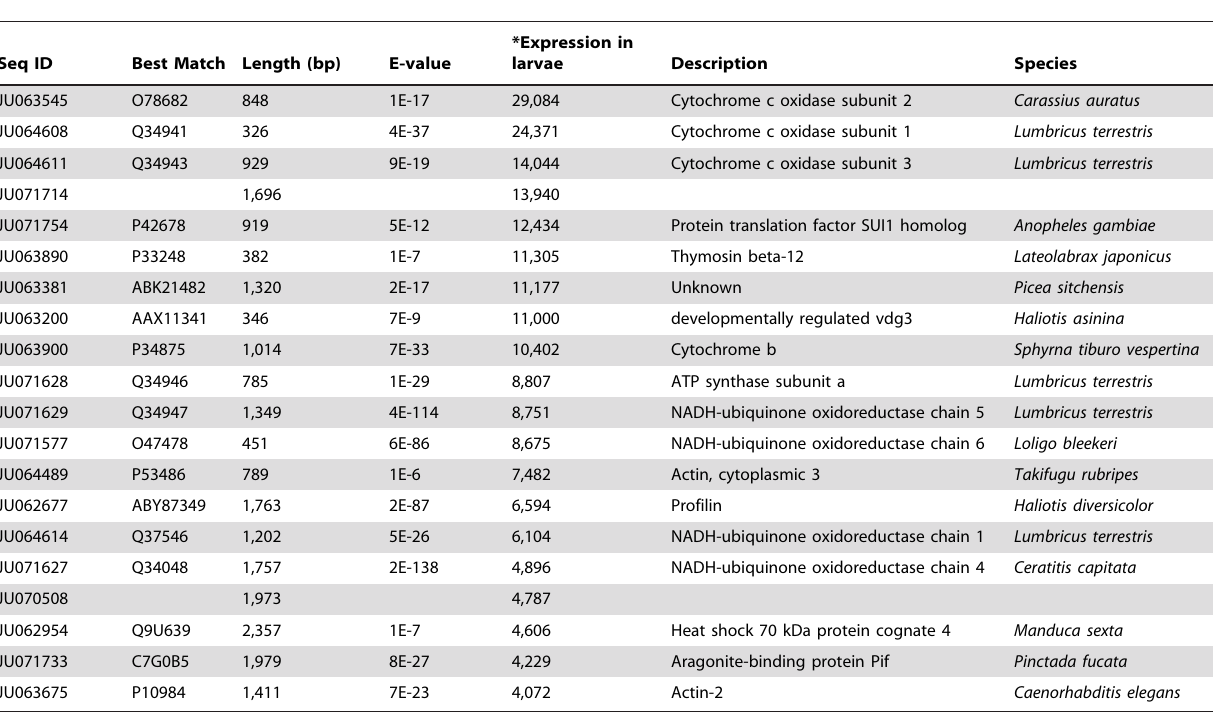
Table 2. The top 20 highly expressed sequences with their associated BLAST matches (E-value , 1e 2 5).